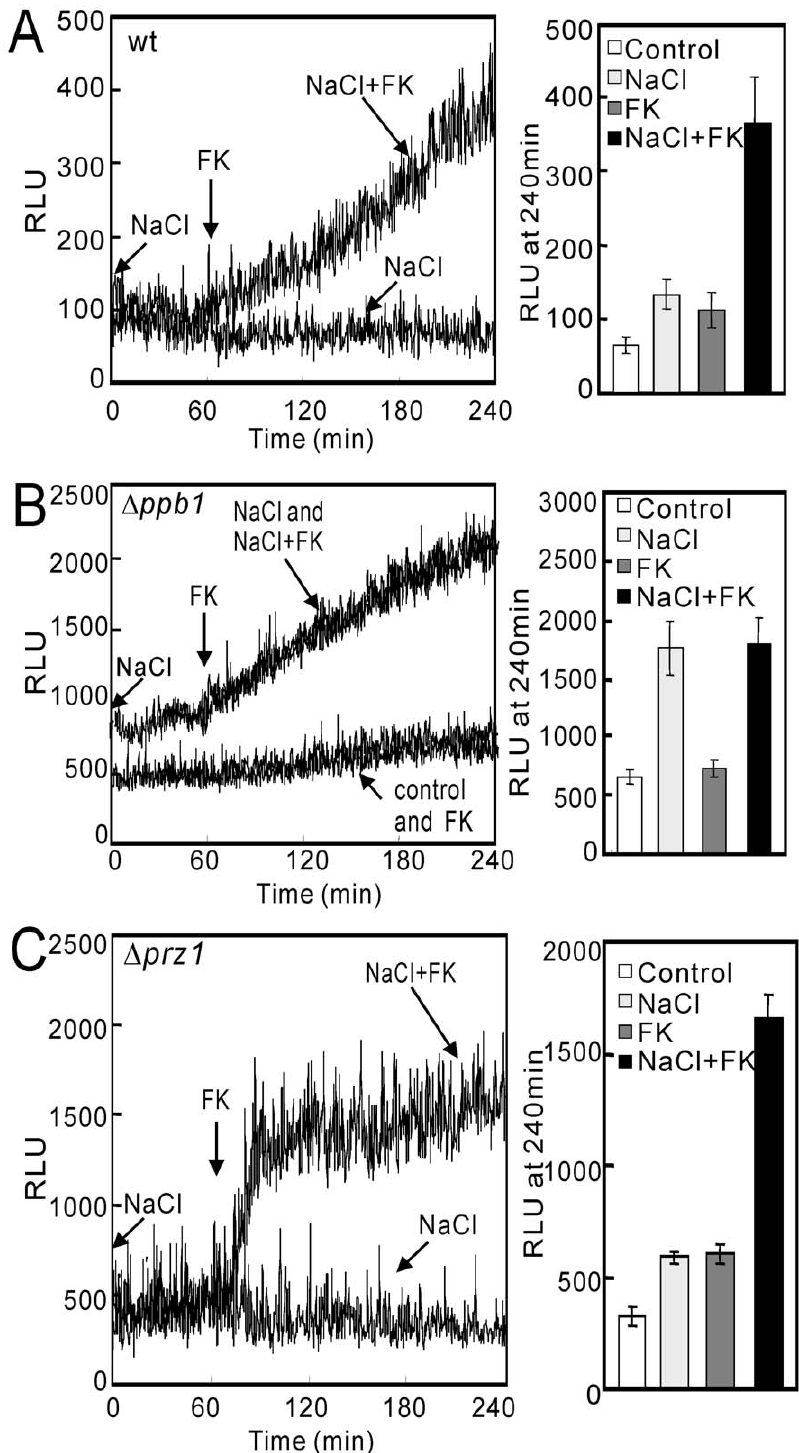
Figure 4. NaCl plus FK506 treatment caused a slow and persistent increase in the cytoplasmic Ca 2 + level. The wild-type (A), D ppb1 (B) or D prz1 (C) cells harboring pKB6892 were cultured as described in Figure 2B. A 10 m l volume of distilled water or 2 M stock of NaCl were added into the 96-well plate, and then 90 m l volume of cells were rapidly added to each sample. The cells were incubated for 30 min to reach a steady-state cytoplasmic Ca 2 + level and the luminescence was followed for 60 min. Then 2 m l of distilled water or FK506 with a concentration of 50 m g/ml were added to the samples and the luminescence was monitored up to 240 min. Left panel: The data shown are representative of multiple experiments. Right panel: The data represent the means 6 standard deviations of RLU taken at 240 min from three independent experiments, and each sample was analyzed in duplicate.